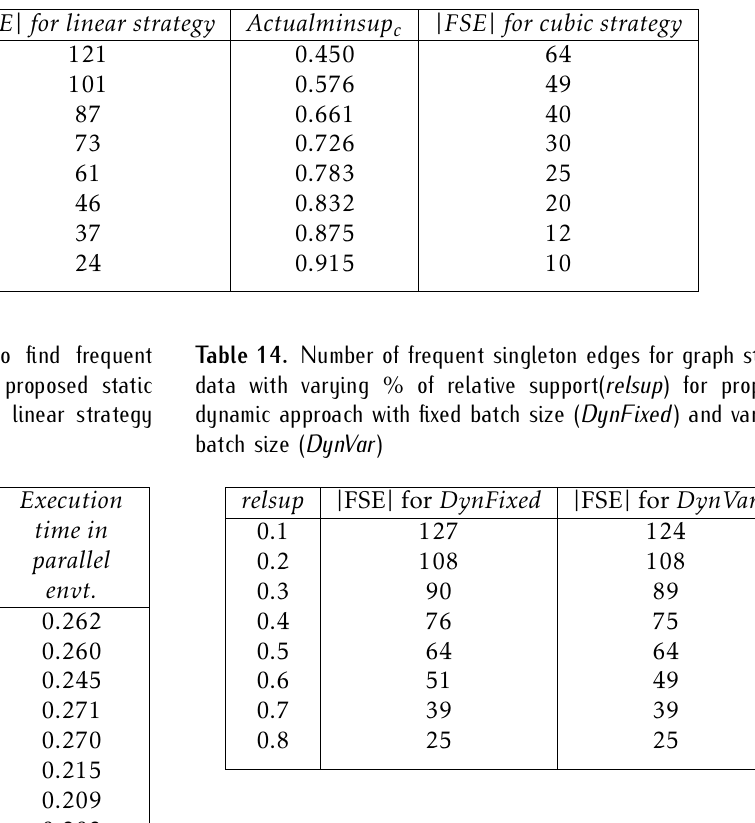
Table 11. Number of frequent singleton edges (|FSE|) for graph stream data with varying minsup for proposed static approach with actual minimum support using linear strategy with and cubic strategy